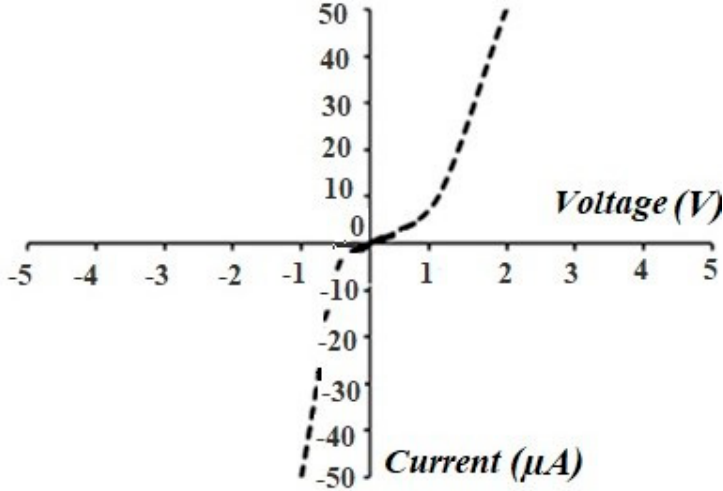
Figure 11. Current voltage characteristics of the SiO 2 ZrO 2 film thermally treated at 500 °C.